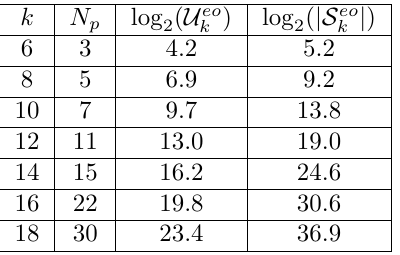
Table 4: Comparisons between U eo